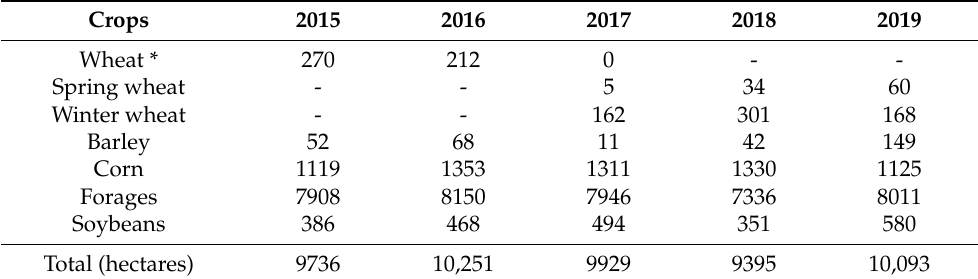
Table 6. Hectares of crops produced within the marsh bodies of Nova Scotia.